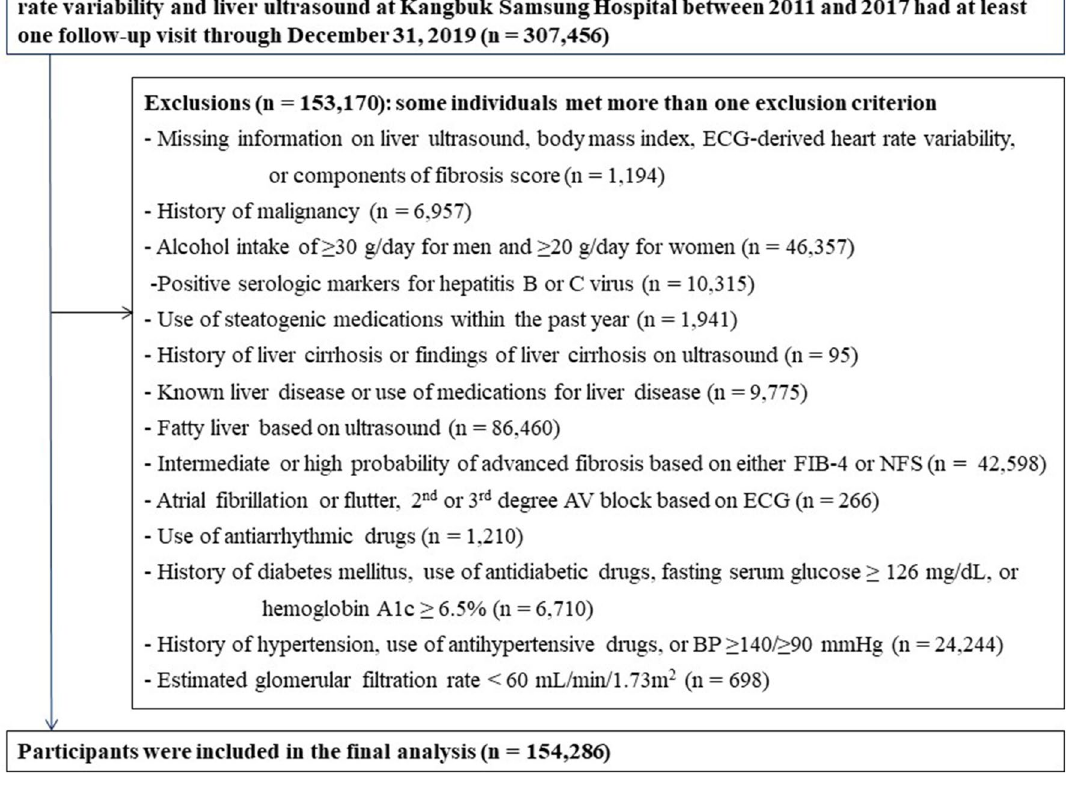
Figure 1. Flowchart of study